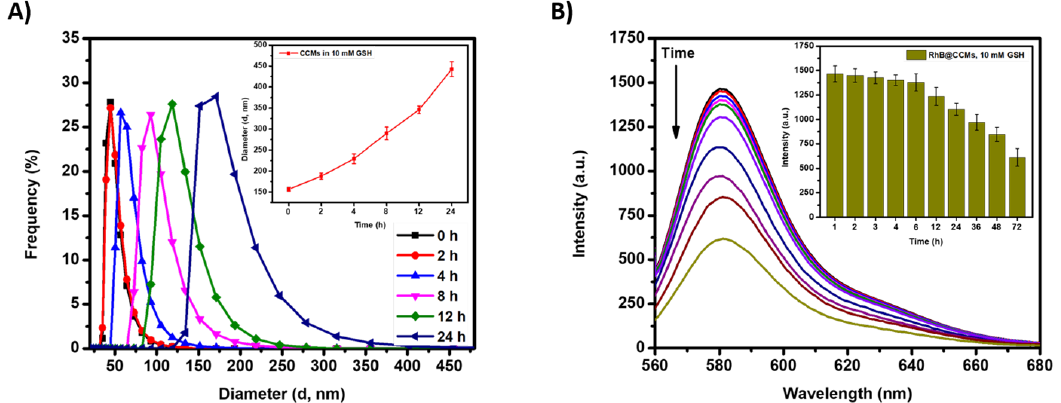
Figure 4. Particle size distribution of CCMs treated with 10 mM GSH ( A ); fluorescent emission spectra of RhB@CCMs treated with 10 mM GSH ( B ) for 72 h ( n = 3). The inset in image A refers to the time dependent change in D h and the inset in image B shows quantitative fluorescent detraction of RhB@CCMs in the presence of 10 mM GSH.